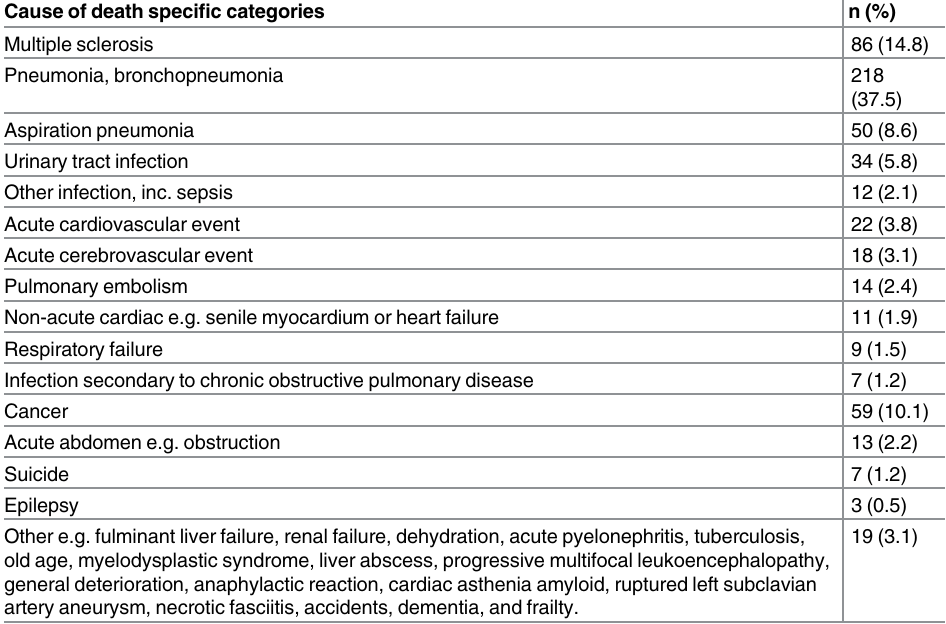
Table 1. Cause of death of 582 people with MS, UKMSTB January 1998 to February 2015. Cause of death speci fi c